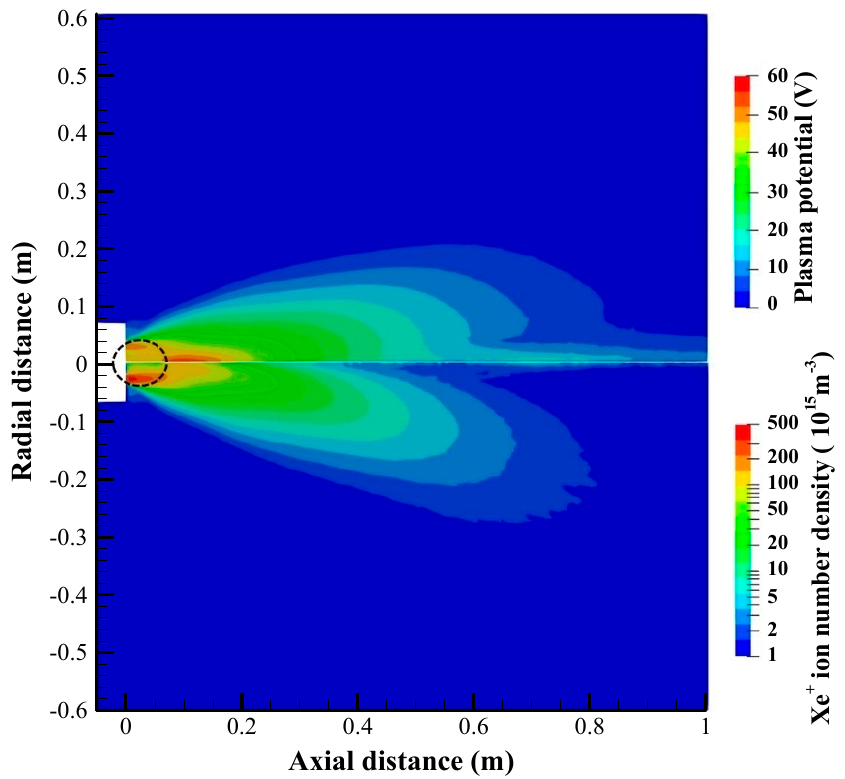
Figure 4. Contours of the plasma potential ( top ) and Xe + ion number density ( bottom ) for Case 1. Figures 5 and 6 compare the distributions of the plasma potential vs. radial distance at x = 10, 50, and 500 mm and with experimental data. Due to the availability of the experimental data [22,23], the conditions of Case 1 and Case 2 were used for the